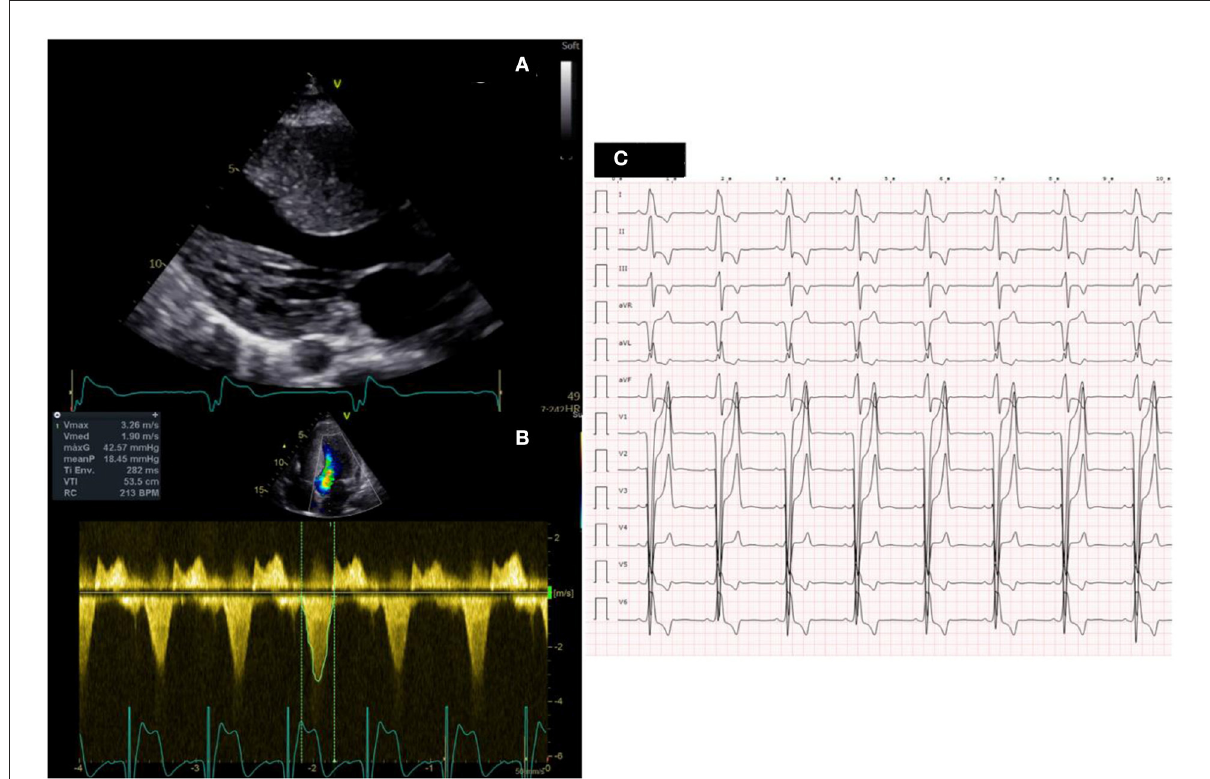
FIGURE2 Clincal test after surgery. (A) Left parasternal long axes showing significant reduction of interventricular septal thickness. (B) Doppler across the left ventricular outflow tract showing a peak gradient of 42 mmHg. (C) ECG after surgery showing the presence of a complete left bundle brunch